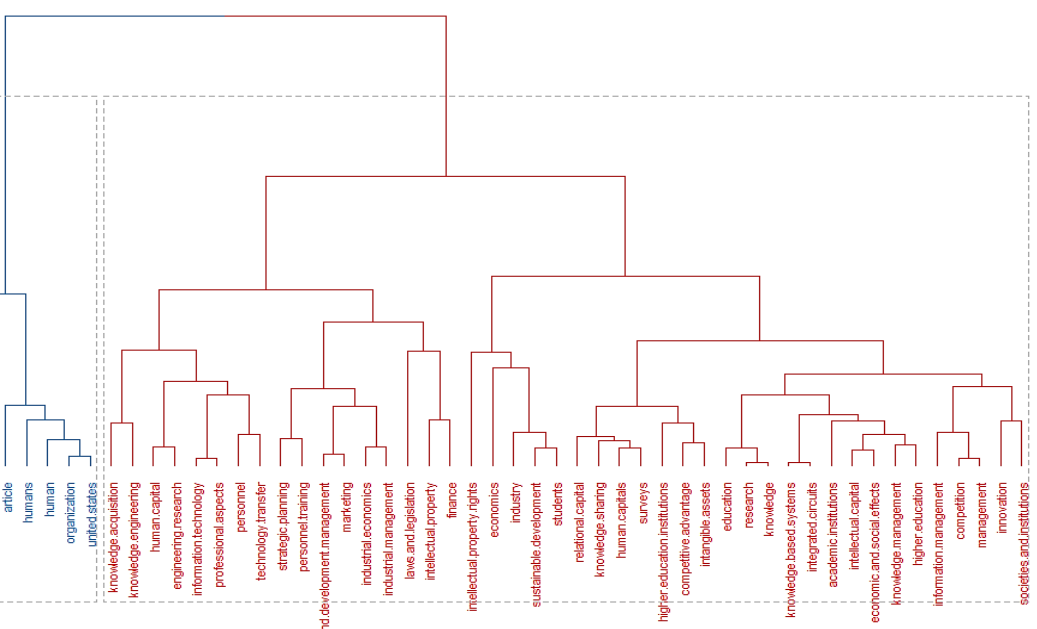
Figure 6. Topic dendrogram for keywords.